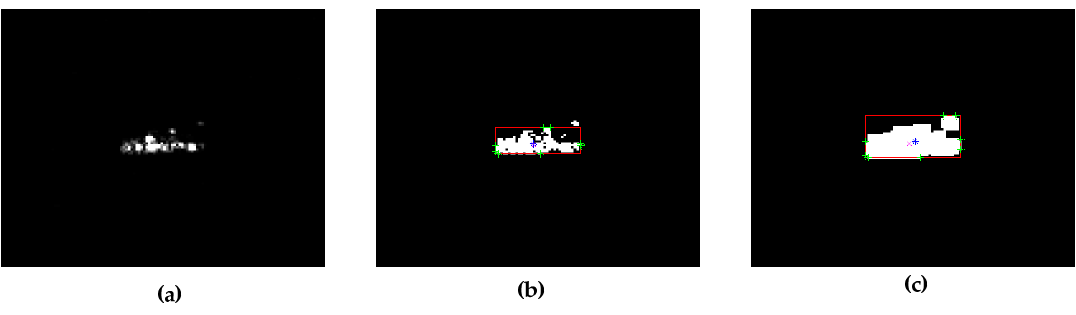
Figure 3. Examples of baseline features. ( a ) A SAR chip processed by energy detection; ( b ) A binary image of SAR; ( c ) A dilated binary image of SAR. In ( b , c ), centroid, boundingbox, extreme and center of gravity of target area were marked in blue, red, green and magenta.